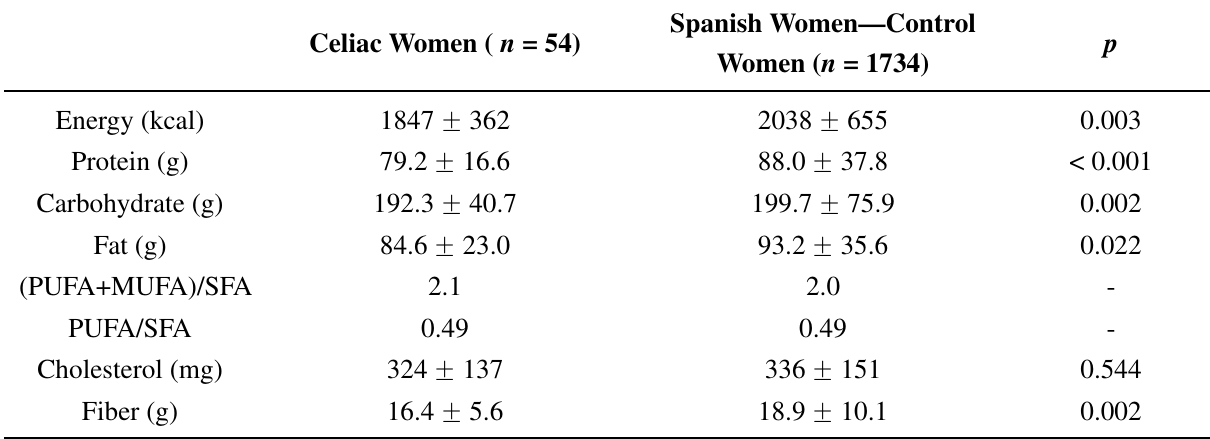
Table 2. Energy and nutrient distribution in celiac and Spanish women.